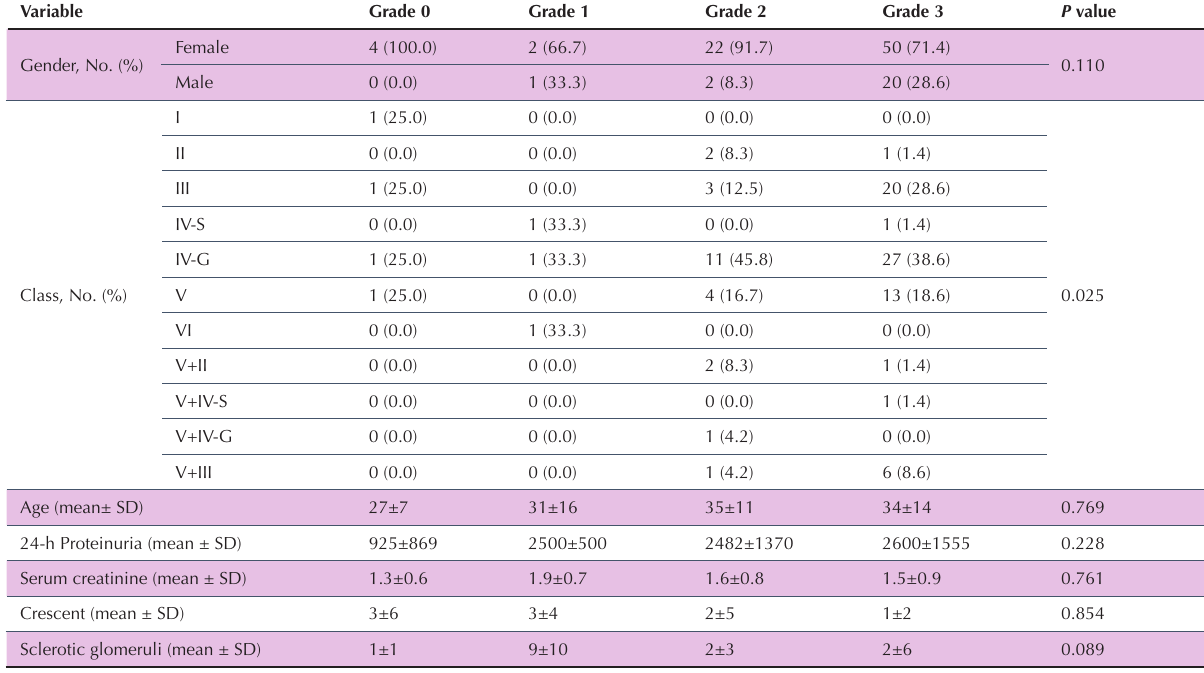
Table 2. Relationships between IgG grade and the study variables